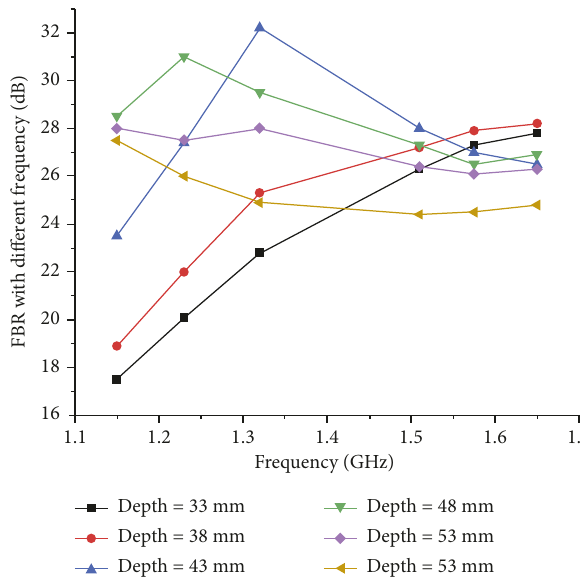
Figure 2: Effect of choke depth on the antenna front-to-rear